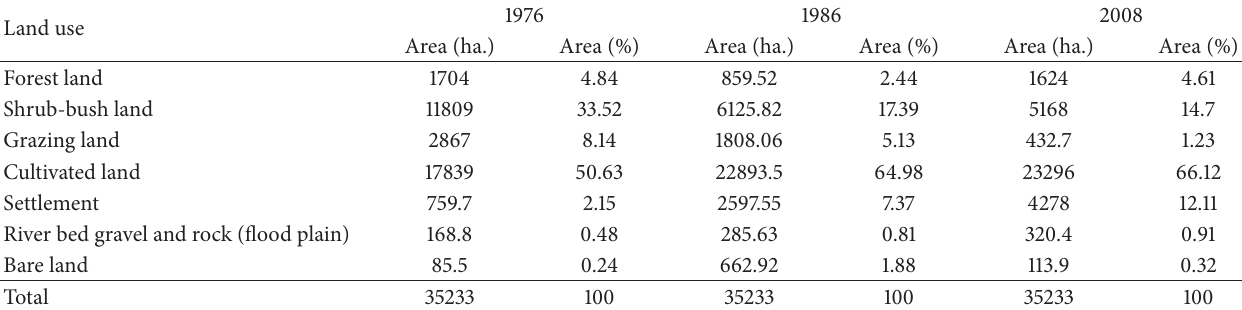
Table 2: Area of land use and land cover types for 1976, 1986, and 2008 in Gilgel Tekeze catchment. Land